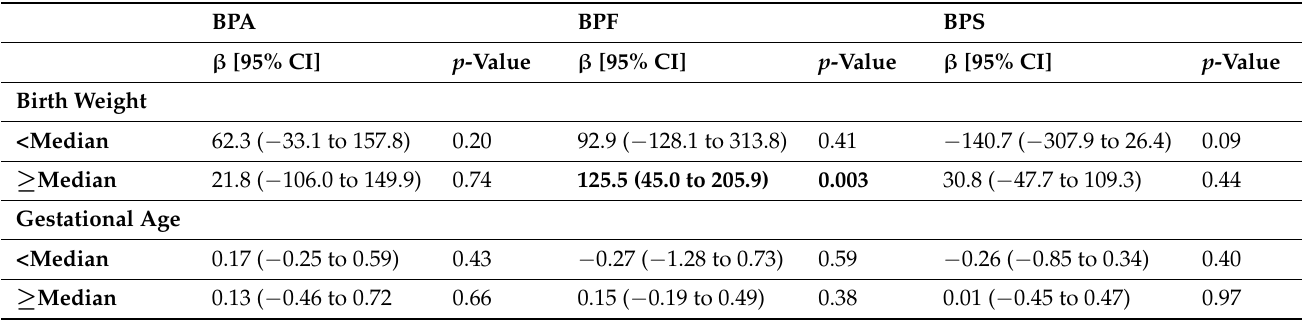
Table 4. Associations of the bisphenol concentration with birth weight and gestational age stratified by their median